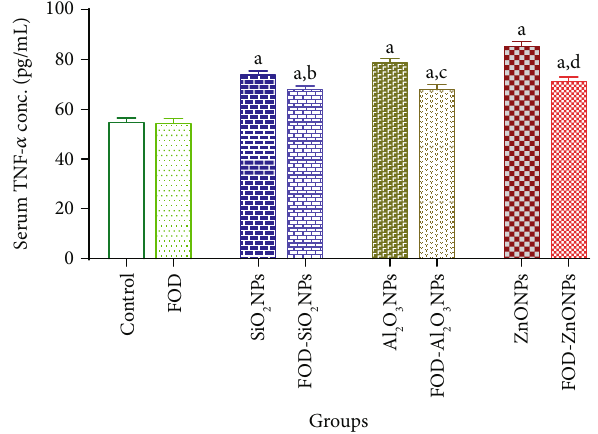
Figure 2: The e ff ects of fi g with olive oil and date-palm fruit extracts (FOD) on the serum tumor necrosis factor- α (TNF- α ) in rats treated with di ff erent nanoparticles (NPs) for 75 days. a p < 0 : 05 versus control group; b p < 0 : 05 versus SiO O NPs; d p < 0 : 05 versus ZnONPs. N.B: the antioxidants versus Al 2 3 (FOD) treatments were used for 2 weeks before and during the administration of the nanoparticles.